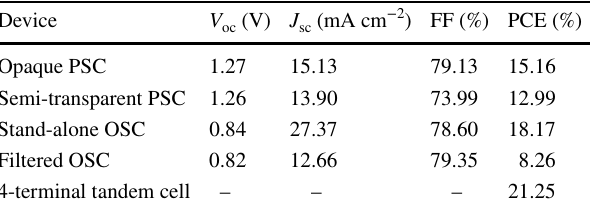
Table 1 Performance data for opaque and semi-transparent CsPbI 2 Br perovskite solar cells, stand-alone and filtered organic solar cells, and 4-T tandem solar